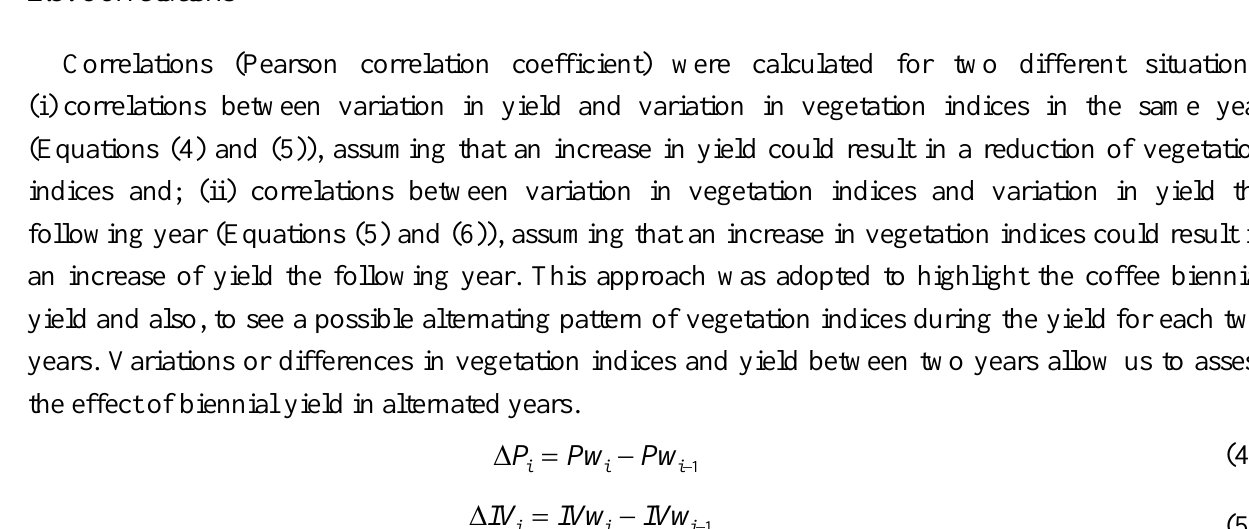
Table 1. Number of yield data samples collected for each year ( n samples when we calculated the difference between 2 years ( n